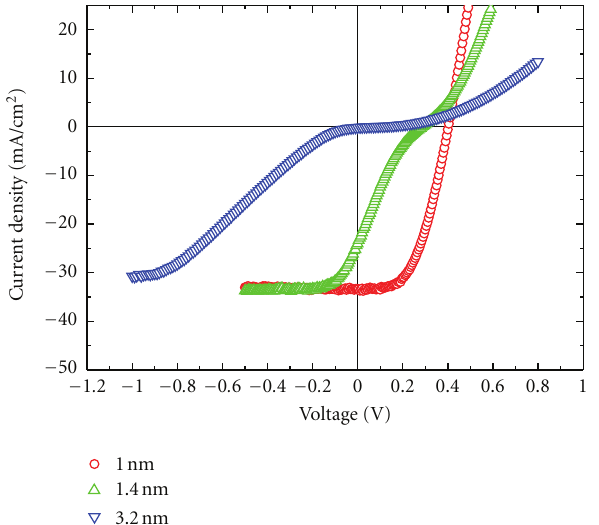
Figure 6: Variation of current density as a function of voltage of silicon oxide layer with thicknesses 1, 1.4, and 3.2 nm formed by rapid thermal annealing